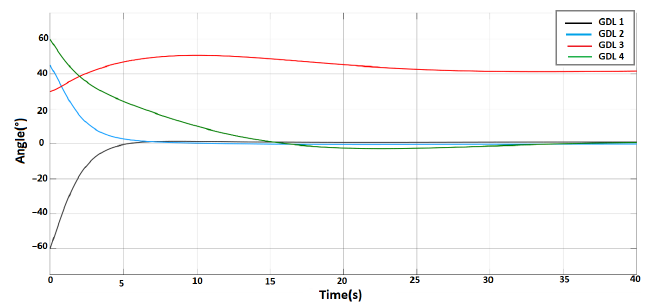
Figure 9. System response to different initial conditions: − 60 ◦ , 45 ◦ , 30 ◦ , 60 ◦ .